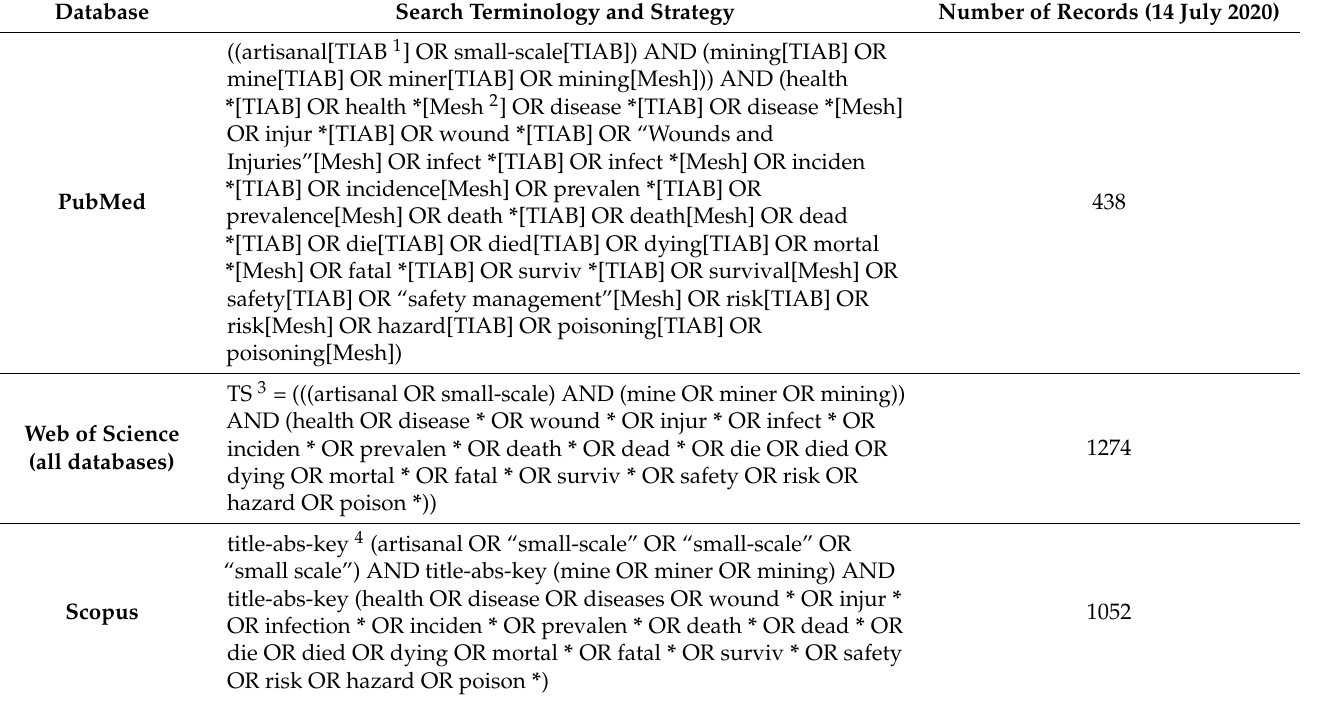
Table A1. Search terminology for the three electronic databases, PubMed, Web of Science, and Scopus. Number of records